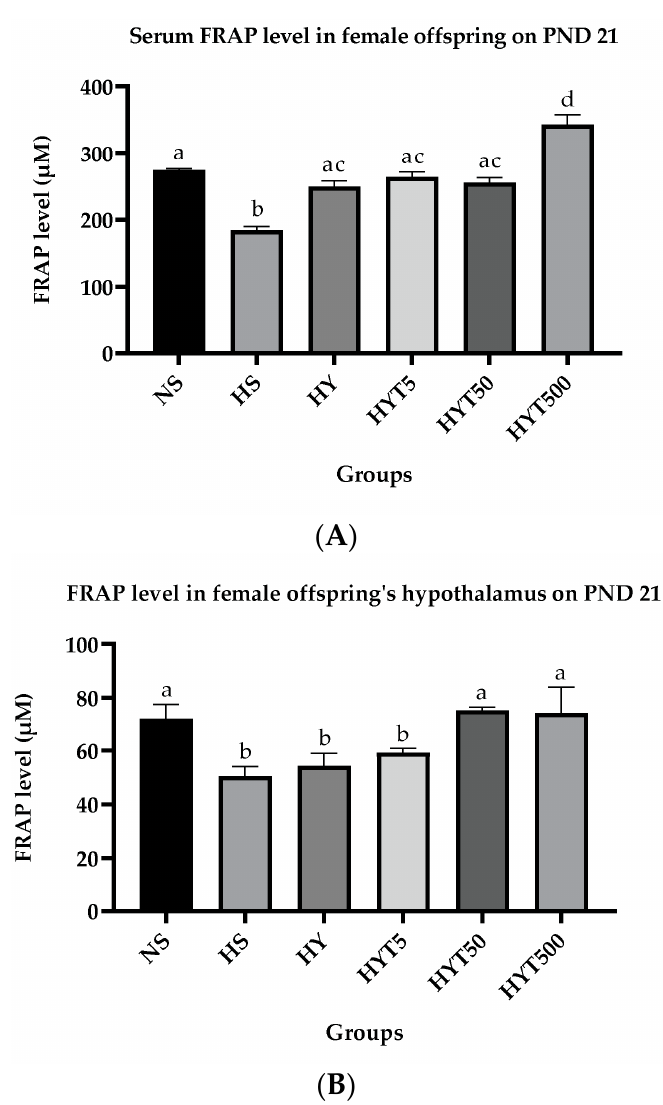
13 of 19 Figure 7. Plasma insulin level of female offspring on PND 21. NS: normal chow and saline; HS: HFD and saline; HY: HFD and yoghurt; HYT5: HFD and 5 mg/kg of E. tapos yoghurt; HYT50: HFD and 50 mg/kg of E. tapos yoghurt; HYT500: HFD and 500 mg/kg of E. tapos yoghurt. Values are ex- pressed as mean ± SEM. Different letters indicate a significant difference at p < 0.05. 3.2. Antioxidant Status 3.2.1. E. tapos Yoghurt Increases FRAP Level in Serum and Hypothalamus in Female Offspring Figure 8A,B shows the FRAP level in the serum and hypothalamus of female off- spring on PND 21. In serum, the FRAP level in female offspring of HS is significantly low ( p < 0.05) compared to NS. The serum level in HY, HYT5, and HYT50 is significantly high ( p < 0.05) compared to HS and shows no significant difference ( p > 0.05) compared to NS. Meanwhile, the serum FRAP level of female offspring in HYT500 is significantly high ( p < 0.05) compared to NS, HS, HY, HYT5, and HYT50 on PND 21. As shown in Figure 8B, the FRAP level in the hypothalamus of female offspring in HS, HY, and HYT5